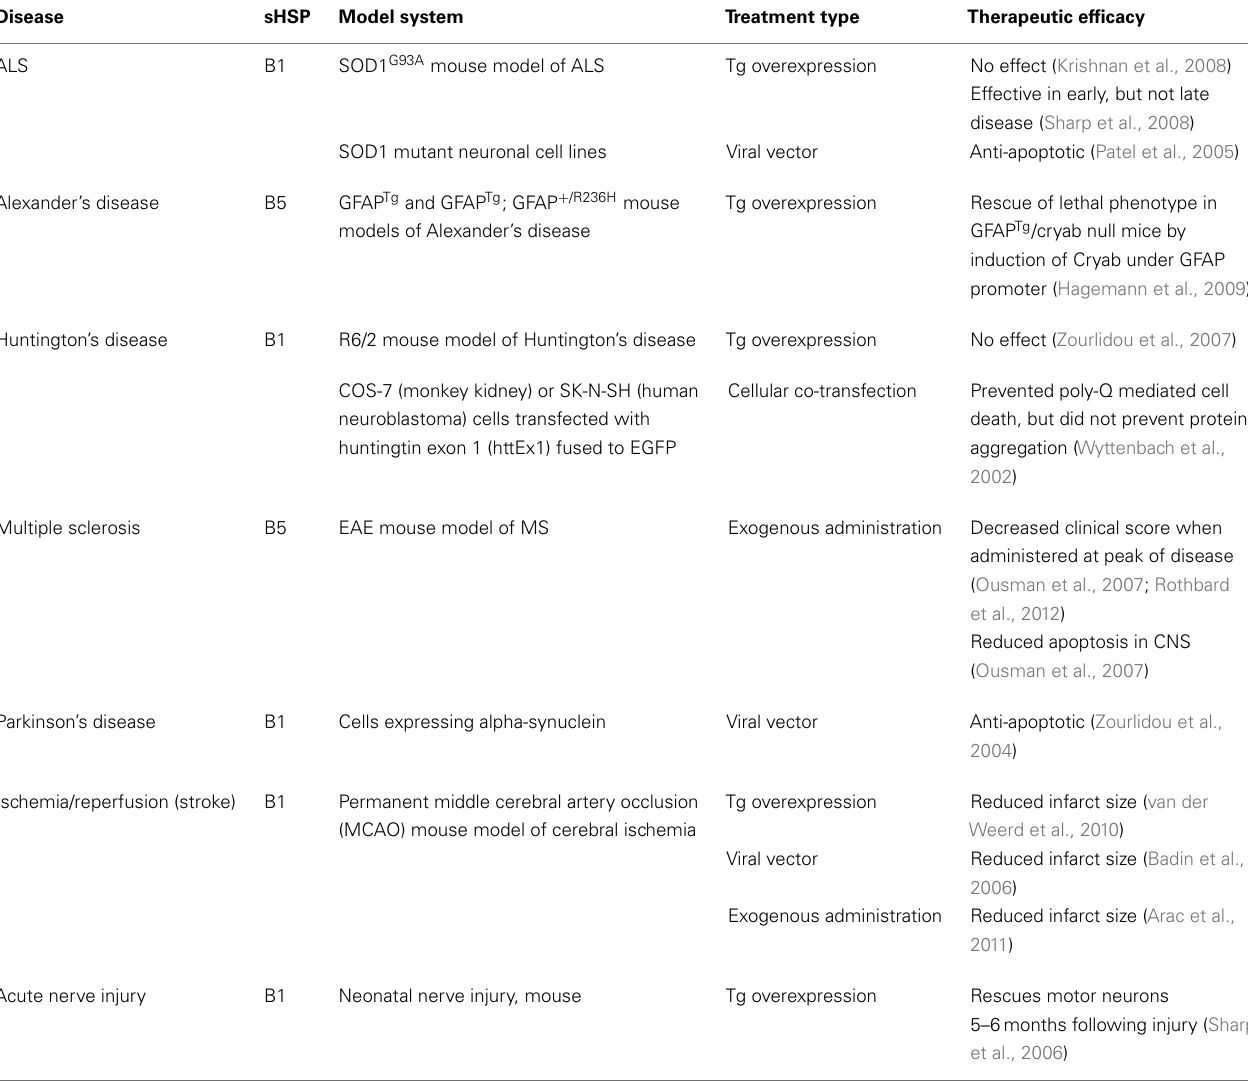
Table 3 | Overexpression and exogenous administration of